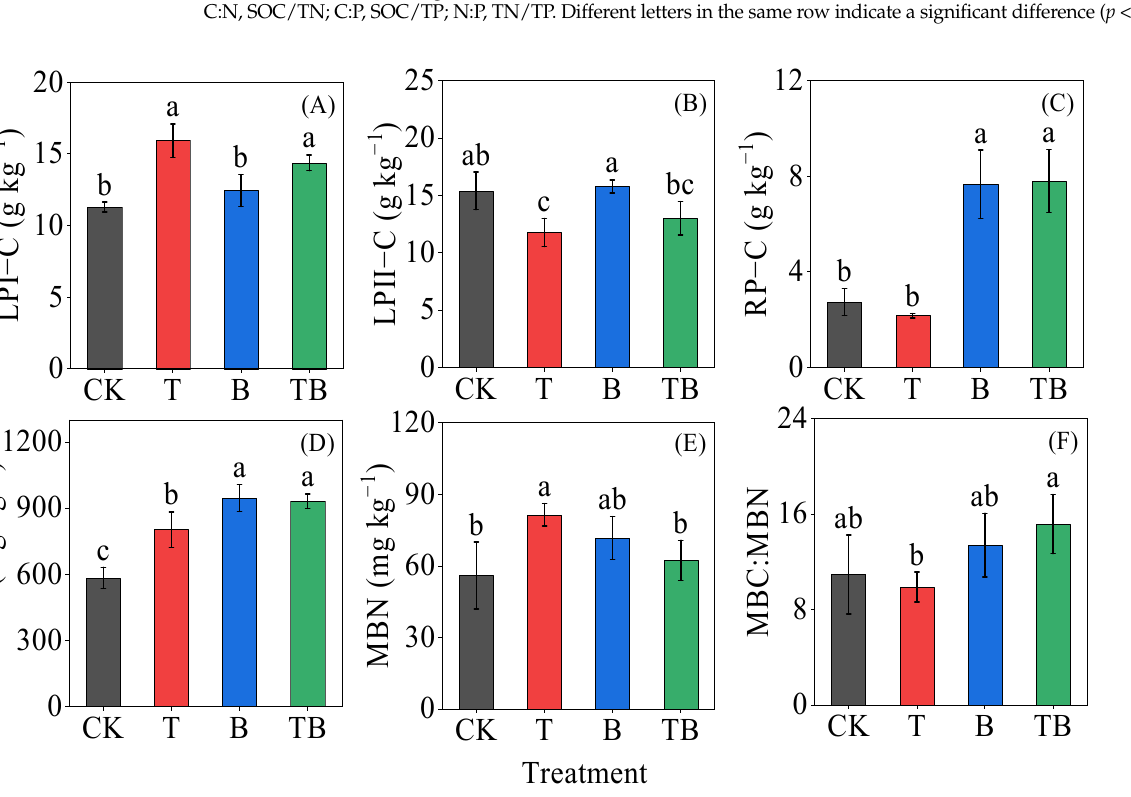
Figure 1. A comparison of labile C pool I (LPI − C) ( A ), labile C pool II (LPII − C) ( B ) and recalcitrant C pool (RP − C) ( C ), soil microbial biomass C (MBC) and N (MBN) and MBC/MBN ( D – F ) (mean ± SE) among the different treatments including the control (CK), oyster shell powder (T), biochar (B) and a combined amendment (TB). Bars with different letters indicate significant differences ( p < 0.05).